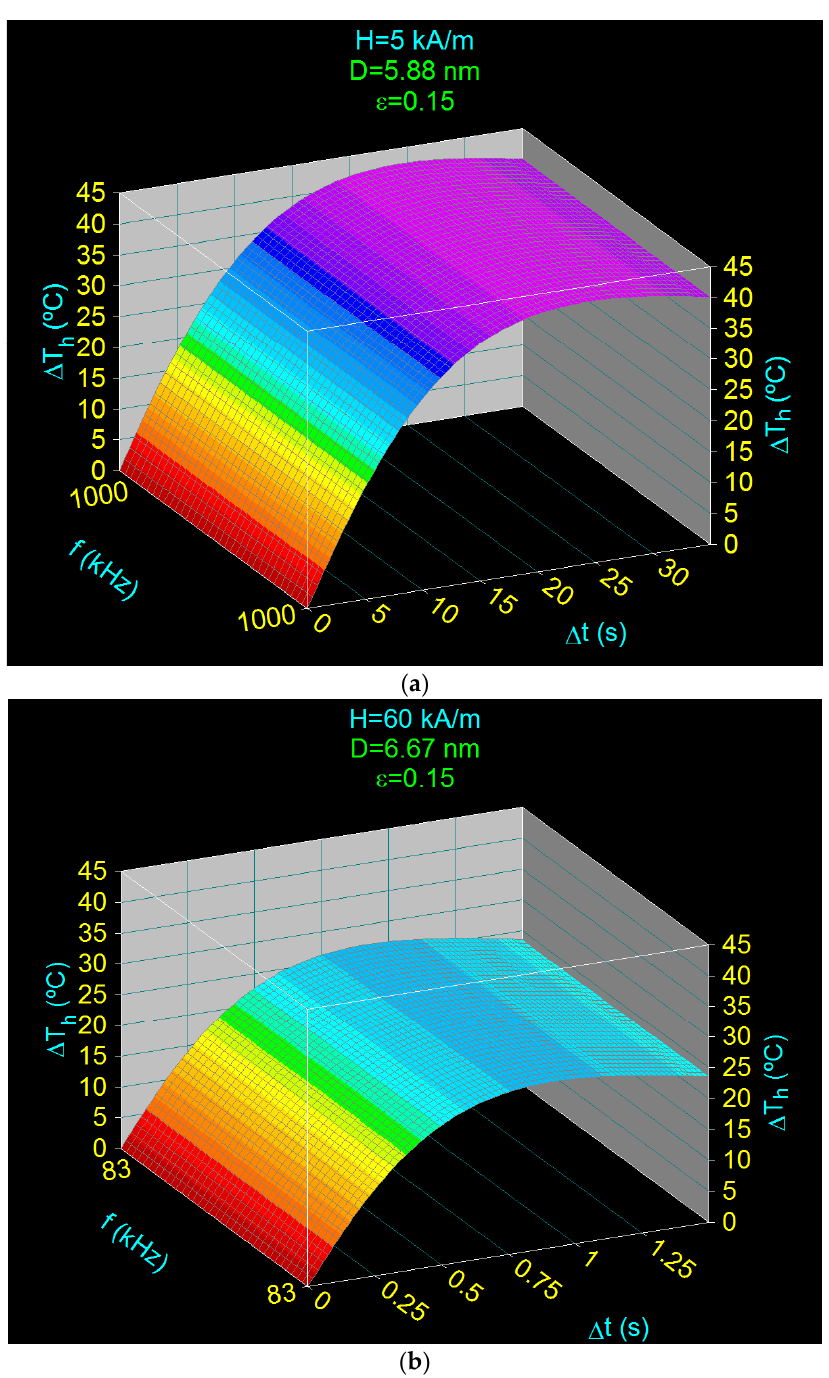
Figure 9. The time variation of heating temperature (ΔT h ) of CoFe 2 O 4 nanoparticles in optimal conditions given in Table 3 for volume fraction of 0.15 and two values of magnetic field: ( a ) 5 kA/m and ( b ) 60 kA/m.